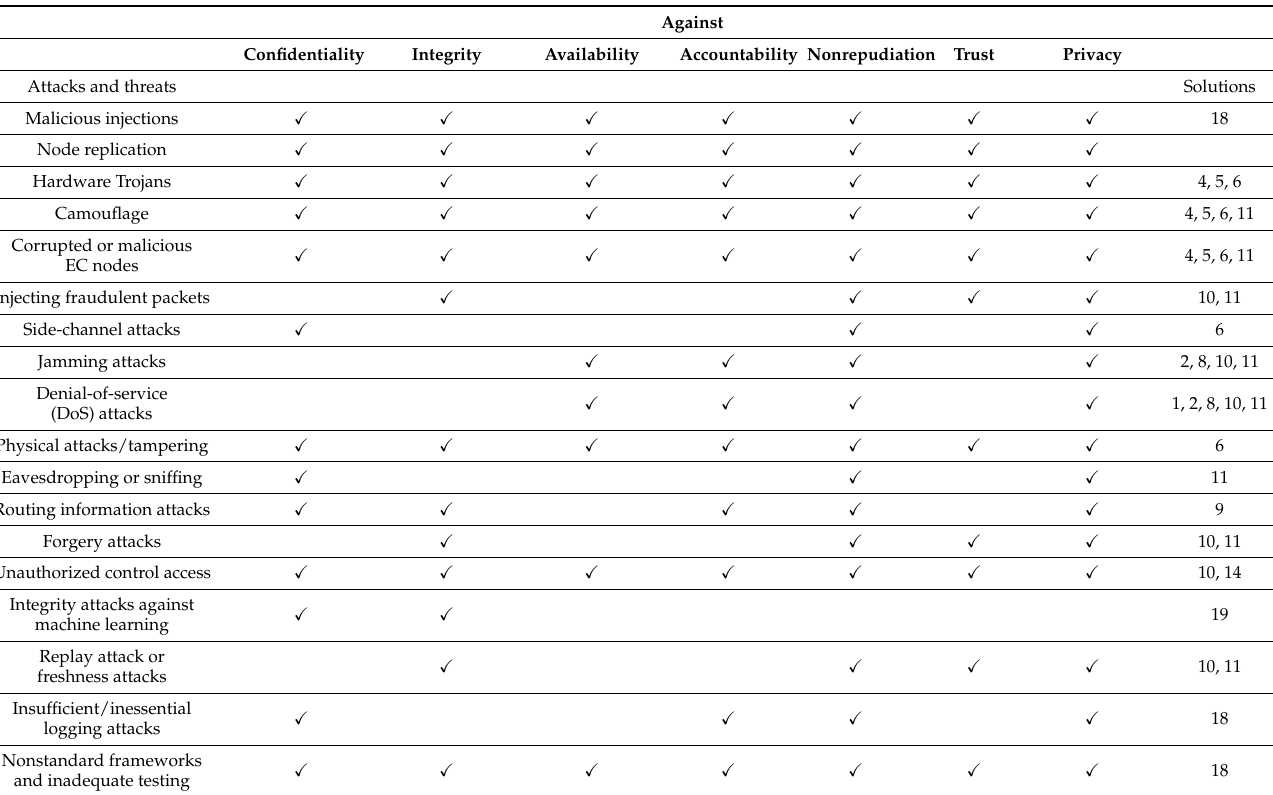
Table 2. Table 3 shows the definitions of the security principles outlined in Table 1. Table 1. Summary of security and privacy attacks and related solutions and